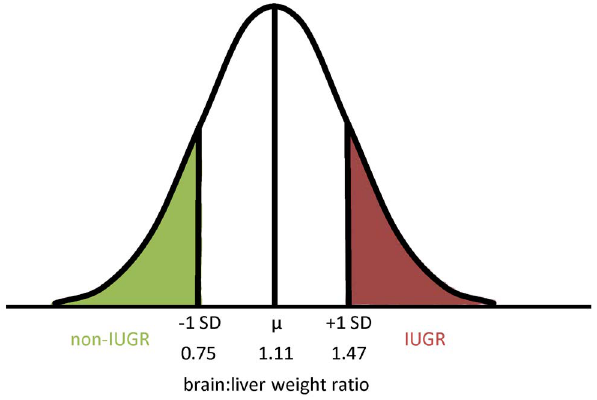
Figure 1. Graphic representation of the distribution of IUGR and non-IUGR fetuses based on brain:liver weight ratios. IUGR fetuses were defined as those with brain:liver weight ratios greater than + 1 SD from the mean (ratio . 1.47), while non-IUGR fetuses were those with brain:liver weight ratios less than -1 SD from the mean (ratio , 0.75) which representative of the top and bottom 16% of the fetal population. doi:10.1371/journal.pone.0109541.g001 PLOS ONE |